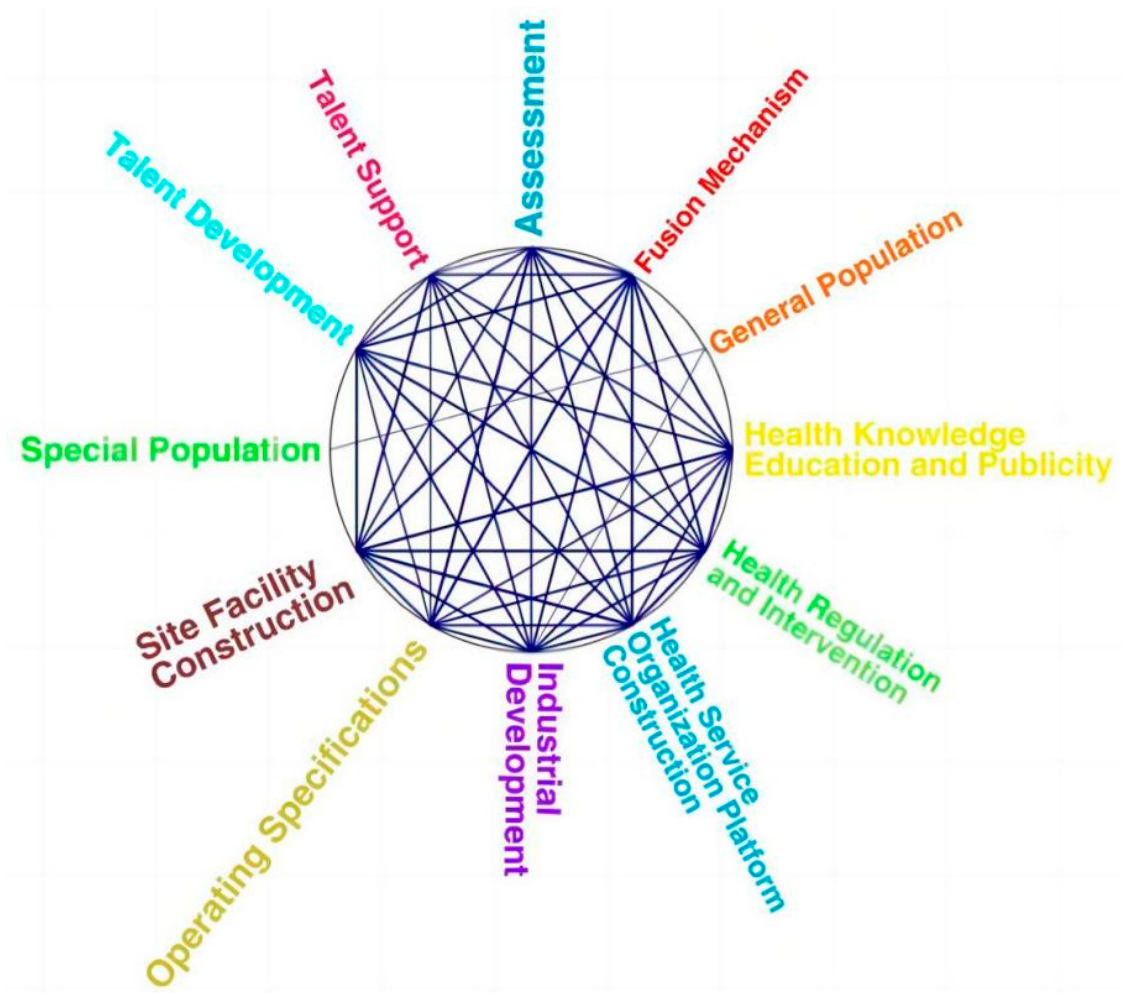
Figure 6. Clustering analysis results based on coding similarity.